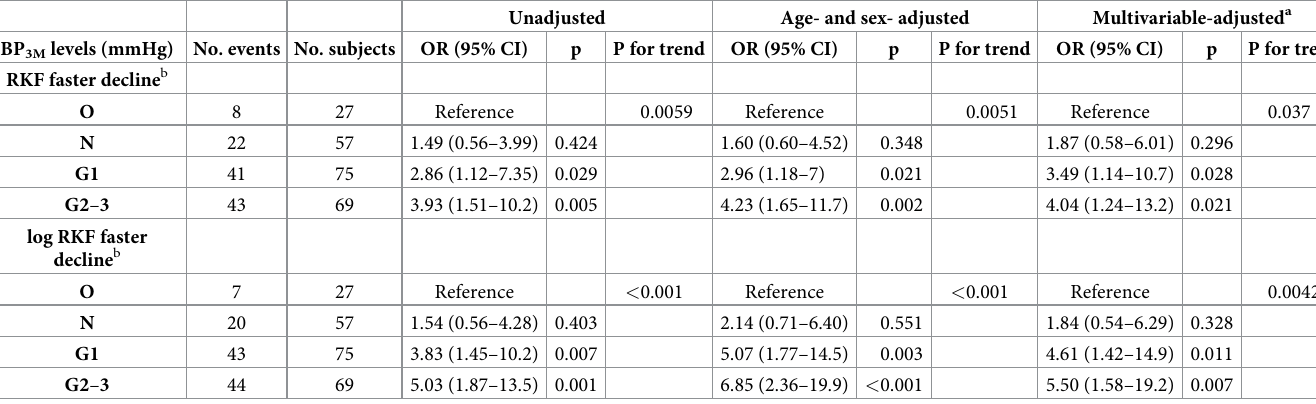
Table 2. Multivariable-adjusted ORs for faster decline rates of RKF and log RKF. Unadjusted Age- and sex- adjusted Multivariable-adjusted a BP 3M levels (mmHg) No. events No. subjects OR (95% CI)